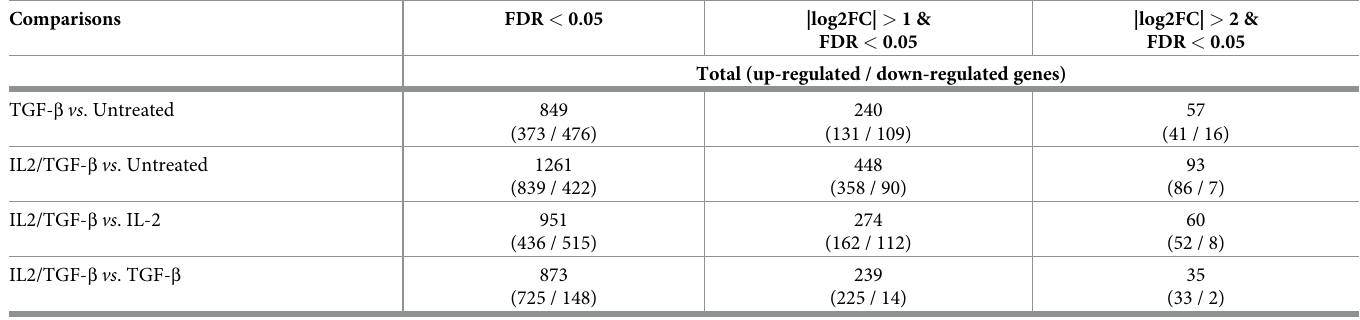
|log2FC| > 2 & FDR < 0.05 FDR < 0.05 Total (up-regulated / down-regulated genes)